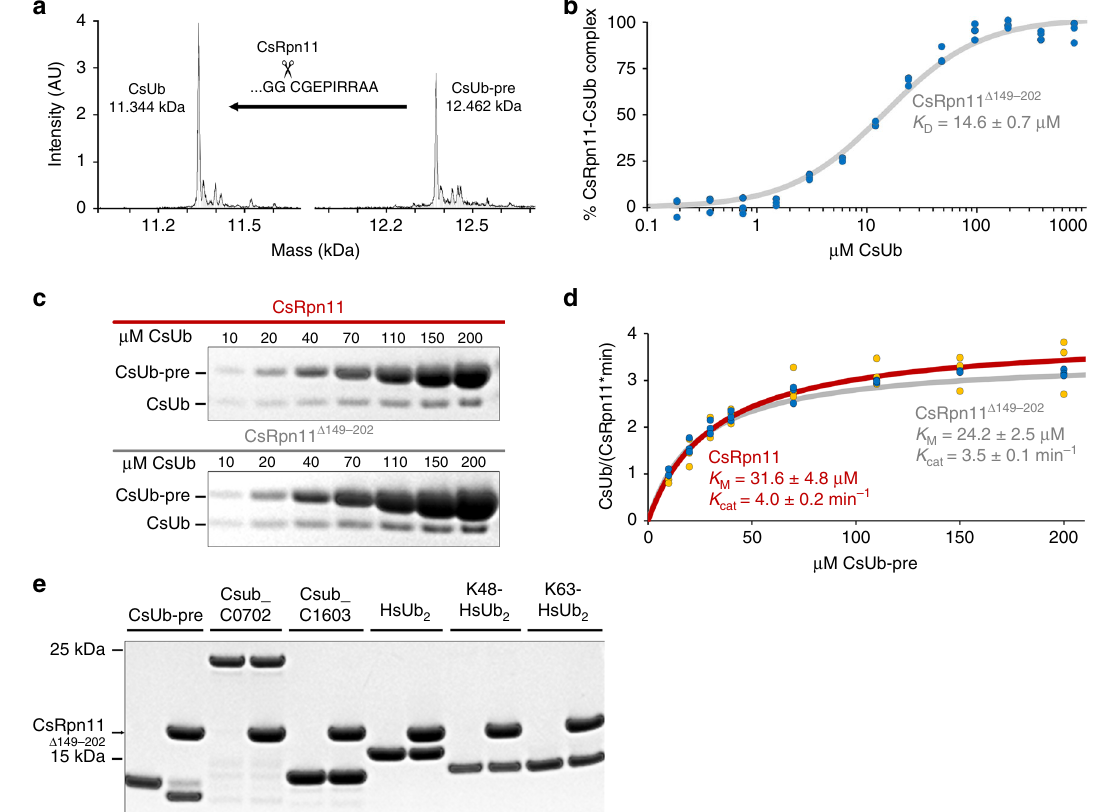
Fig. 4 CsRpn11 speci fi cally processes CsUb precursor (CsUb-pre) at the Gly – Gly motif. a Mass spectrometric pro fi le of CsUb-pre before and after incubation with CsRpn11. The mass of the reaction product, mature CsUb (CsUb), corresponds to CsUb-pre without the nine amino acid fragment succeeding the Gly – Gly motif. All masses refer to N-terminally His 6 -tagged CsUb (see methods). b Microscale thermophoresis (MST)-binding curve for K D determination of the CsRpn Δ 149 – 202 – CsUb interaction based on three independent experiments. c , d Sample gels used for K M determination of CsUb-pre processing by full-length and truncated CsRpn11. The resulting Michaelis – Menten plot is based on three independent experiments. e SDS-PAGE analysis of CsRpn11 substrate speci fi city. CsRpn11 cleaves CsUb-pre but is inactive toward C. subterraneum SAMP precursors Csub_C0702 and Csub_C1603 (CsMoaD), as well as isopeptide- (Lys48 or Lys63) and linearly linked human diubiquitin (HsUb 2 ). The gel shows two lanes for each of the indicated substrates, before (left) and after (right) treatment with CsRpn11 Δ 149 – 202 . The complete gels are shown in Supplementary Fig.